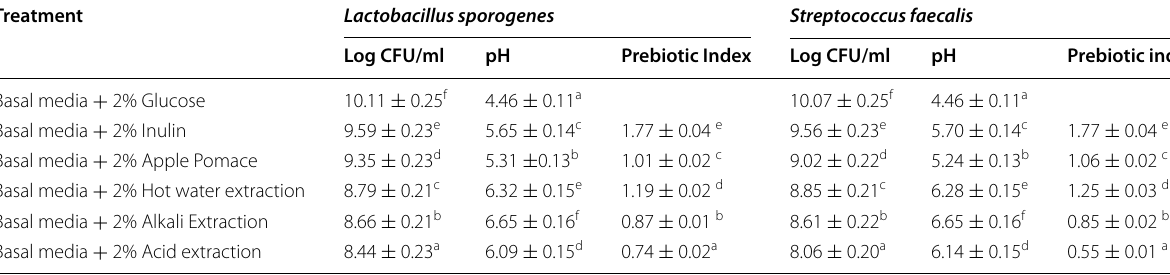
a-f Means with different superscripts within columns significantly differed ( P <0.05)